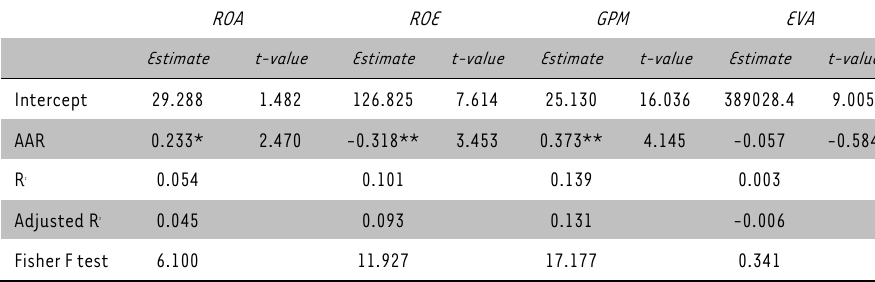
TABLE 5: Multiple regression analyses between AAR and profitability ROA ROE